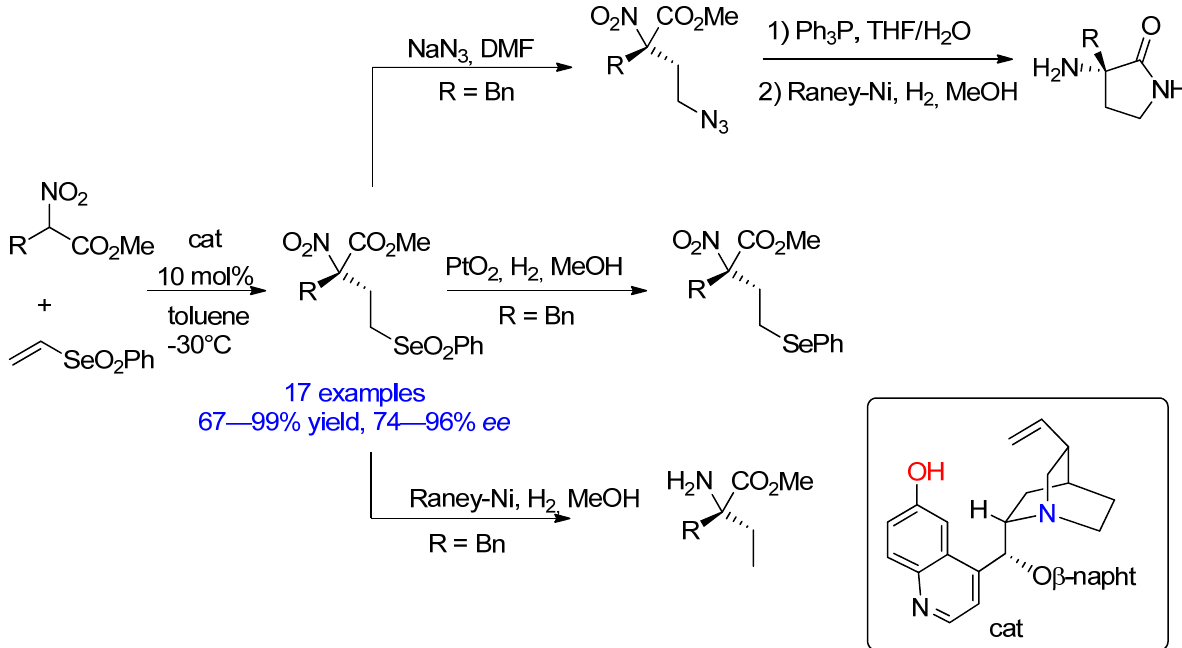
Scheme 28. Enantioselective organocatalyzed Michael additions in ionic liquid and application to the synthesis of a pyr-